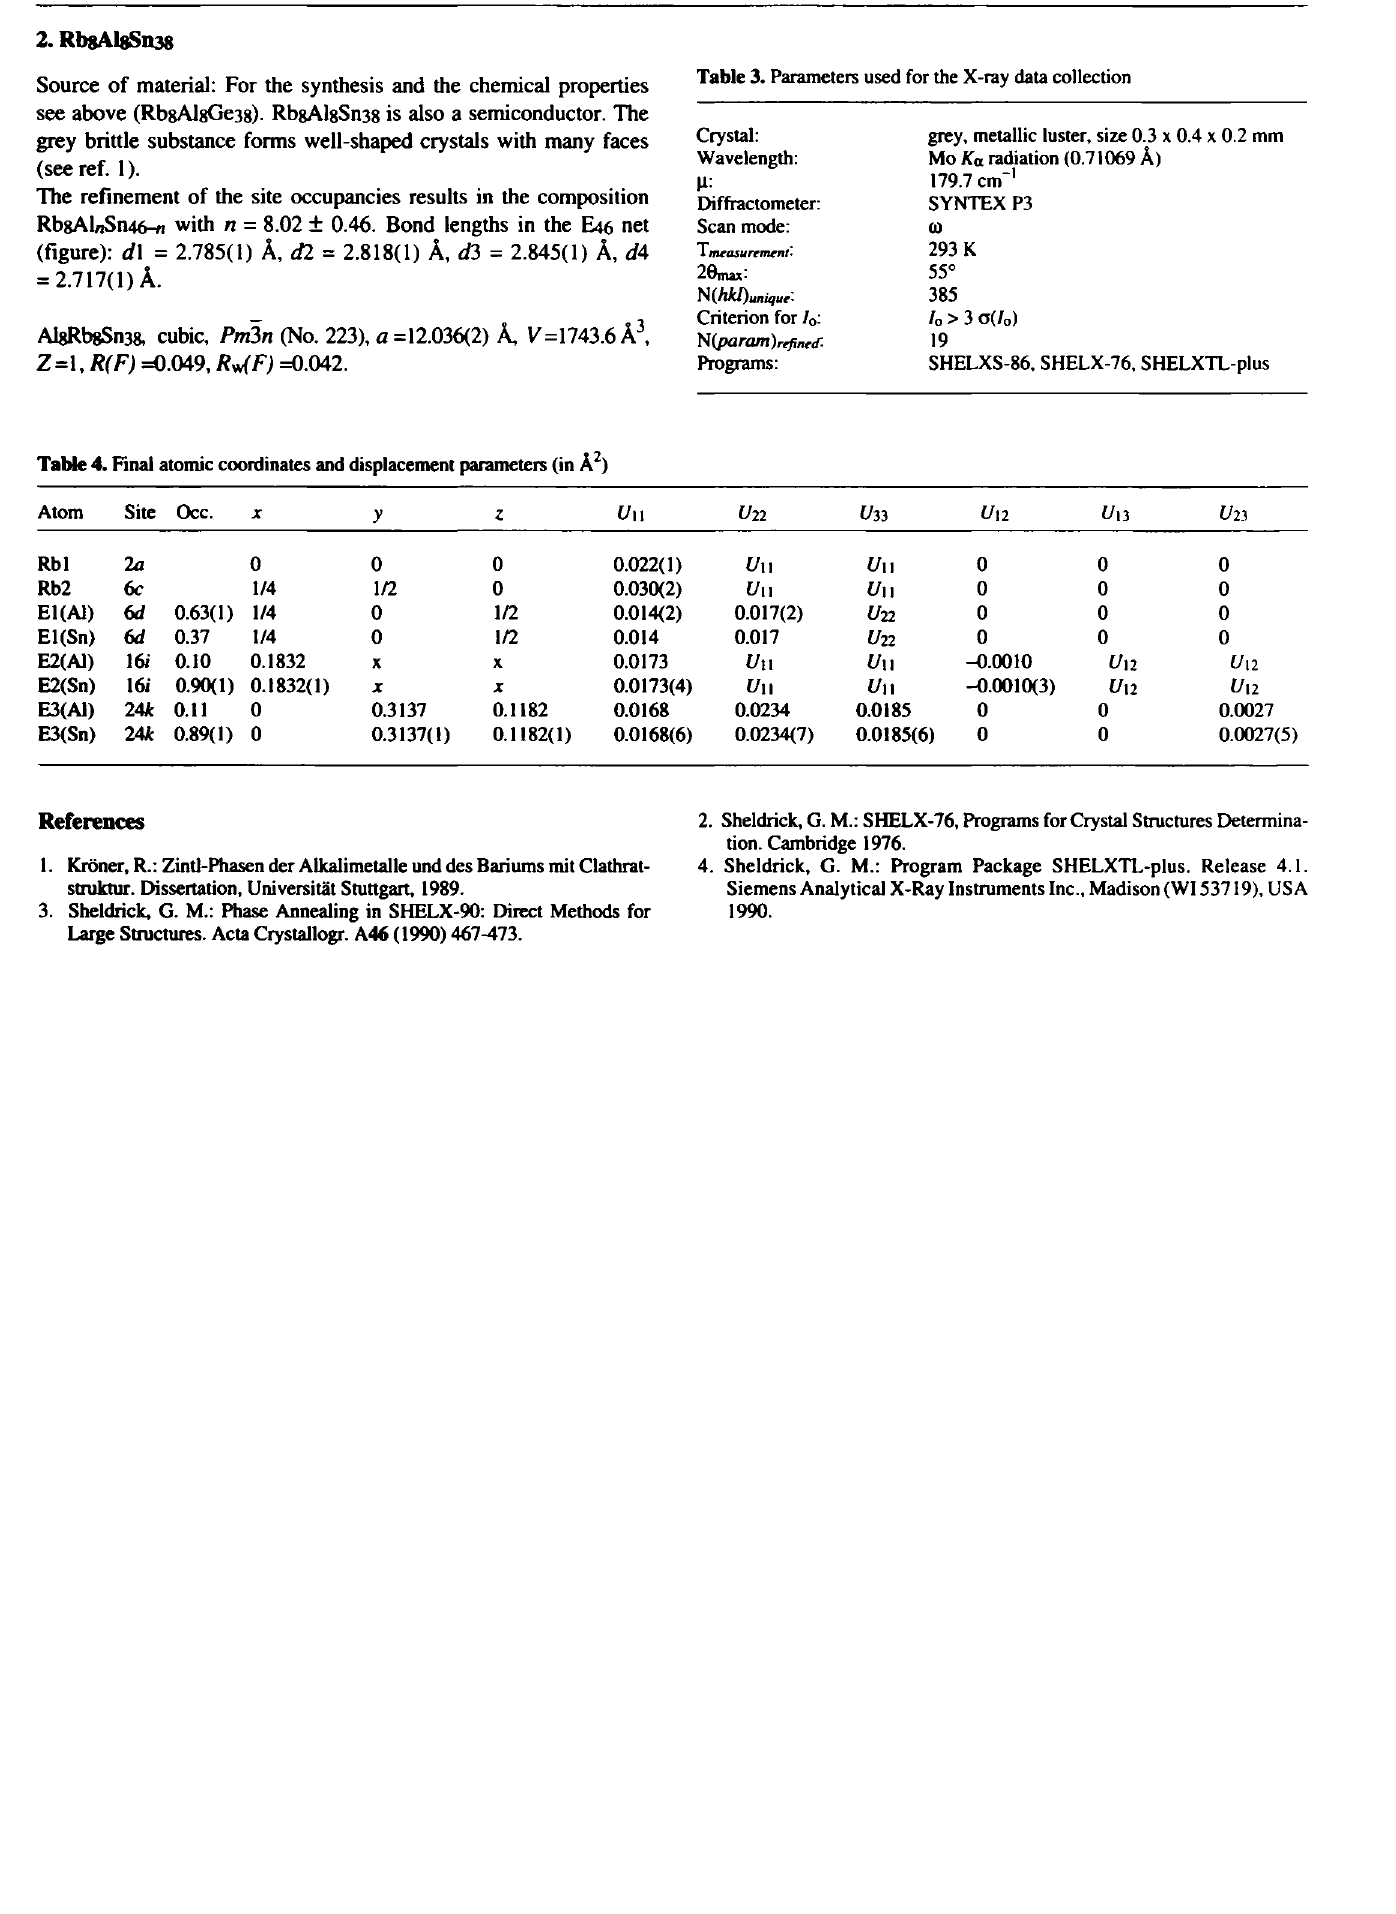
Table 4. Final atomic coordinates and displacement parameters (in Â^) Atom Site